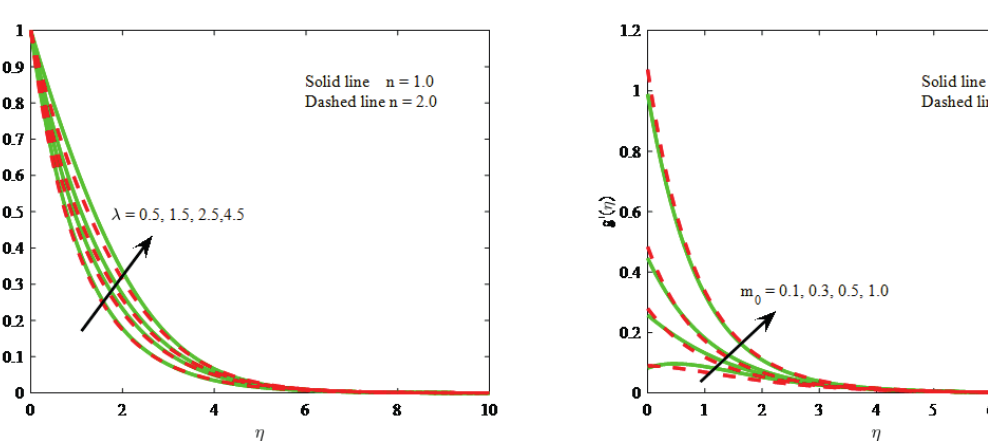
Fig. 8: Impact of λ on velocity.